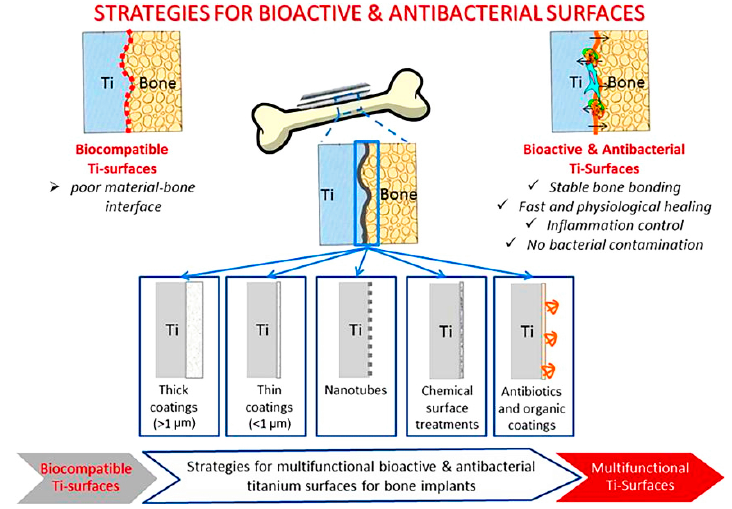
Figure 16. The strategies for achieving bioactive and antibacterial properties on Ti surfaces through various types of surface modifications [176] (reproduced with permission number: 5071090149493, Elsevier). Table 1. The multifunctional properties in Ti and Ti6Al4V alloy, techniques, and surface types.